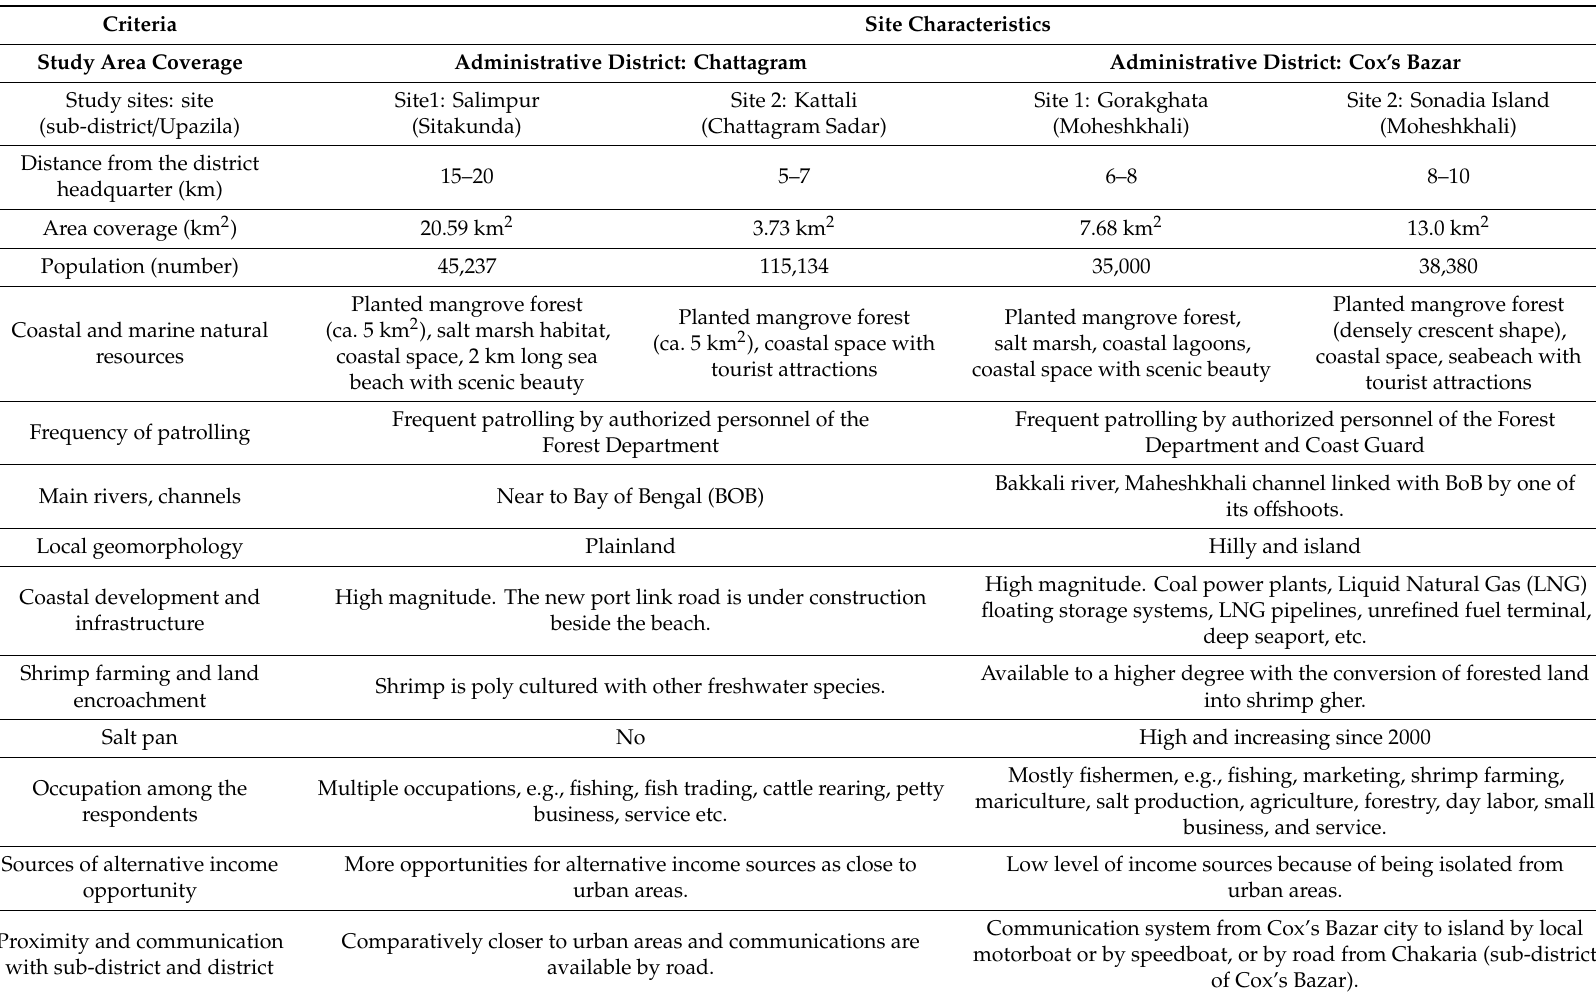
Table 1. Site features, comparative socio-demographic data, and spatial scenarios of study areas along the south-eastern coast of Bangladesh.